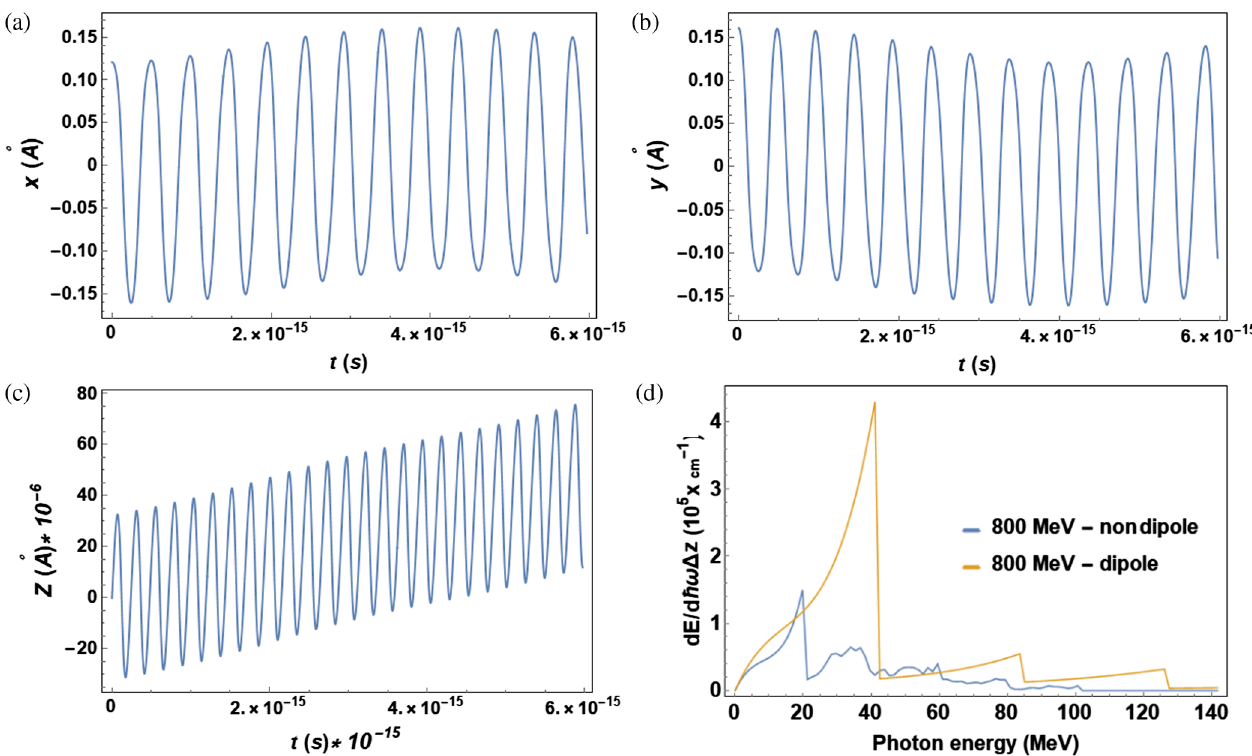
FIG. 3. Electron trajectories relating to the projections shown in Fig. 2. (a) x ð t Þ , (b) y ð t Þ , (c) z ð t Þ . (d) Photon spectrum of one 800 MeV electron incident at the coordinates given in Fig. 2 and channeled along the h 100 i axis of a 20 - μ m-thick W single crystal. Dipole approximation (yellow line) and nondipole approximation (blue line).